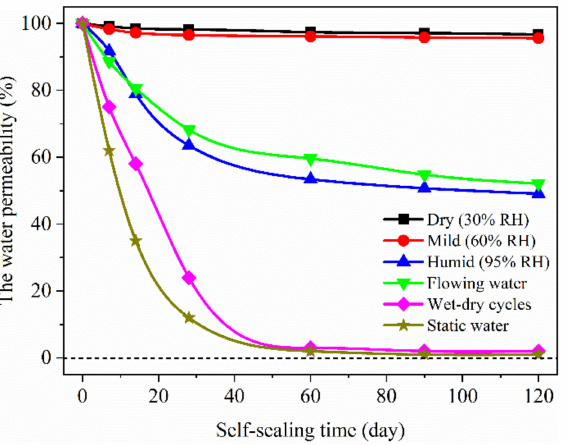
Figure 6. Water permeability for the samples cured in different self-sealing